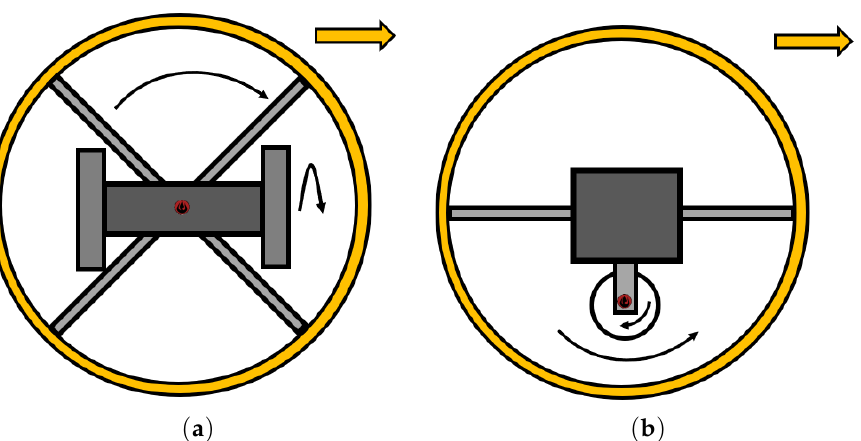
Figure 6. Principle sketches of an angular momentum driving method. ( a ) Mechanism of orthogonally mounted motors. ( b ) Flywheel